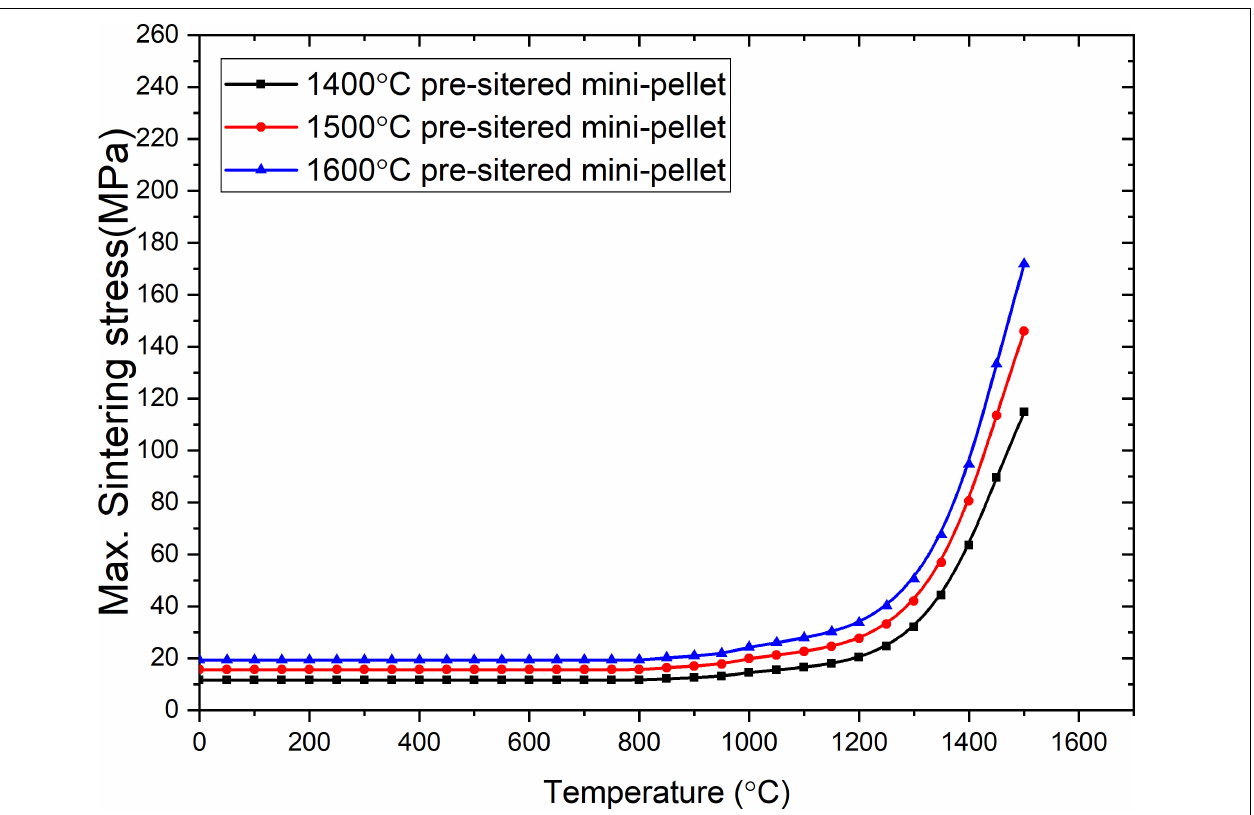
FIGURE 4 | FEA-predicted maximum sintering stresses in YSZ oxide pellet containing a lumped Gd 2 O 3 mini-pellet pre-sintered at 1400 ◦ C, 1500 ◦ C, or 1600 ◦